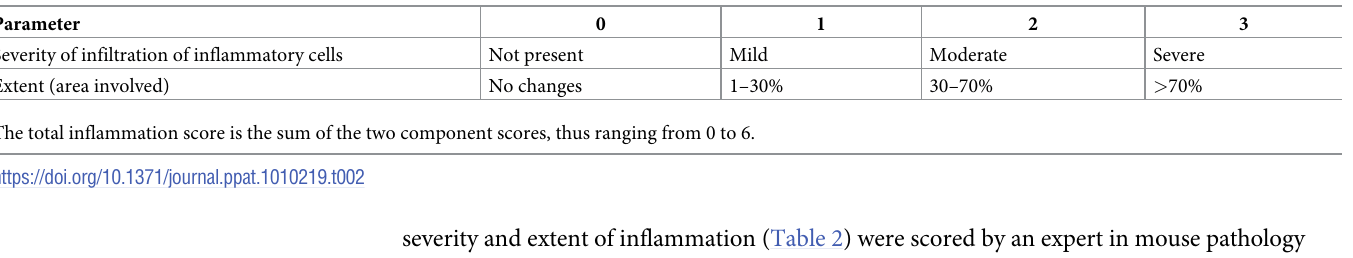
Table 2. Scoring system to assess inflammation in IAV-infected mouse lung.